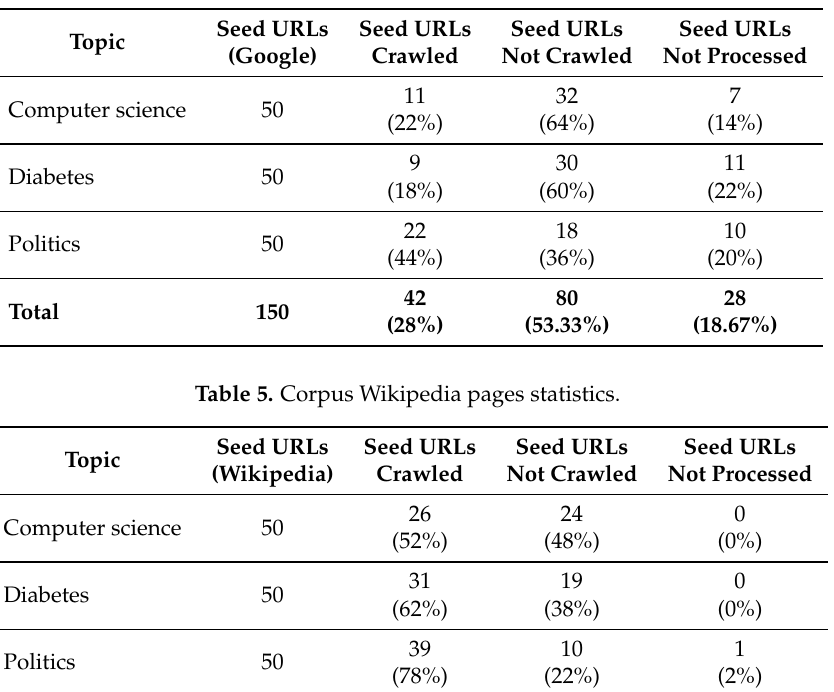
Table 4. Google page results statistics.